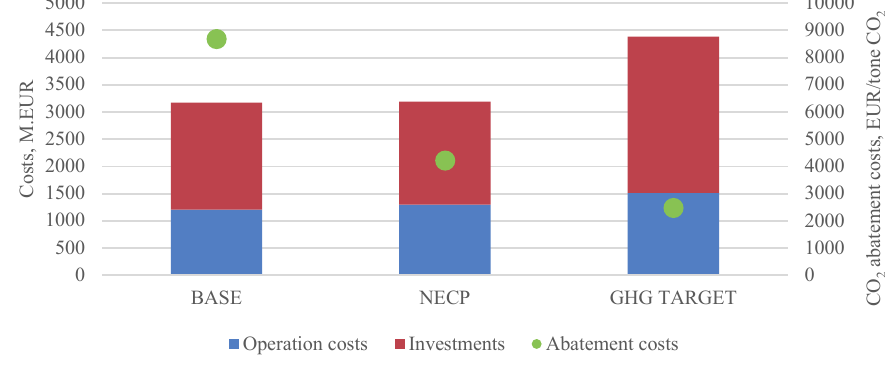
Fig. 19. Projection of costs in each